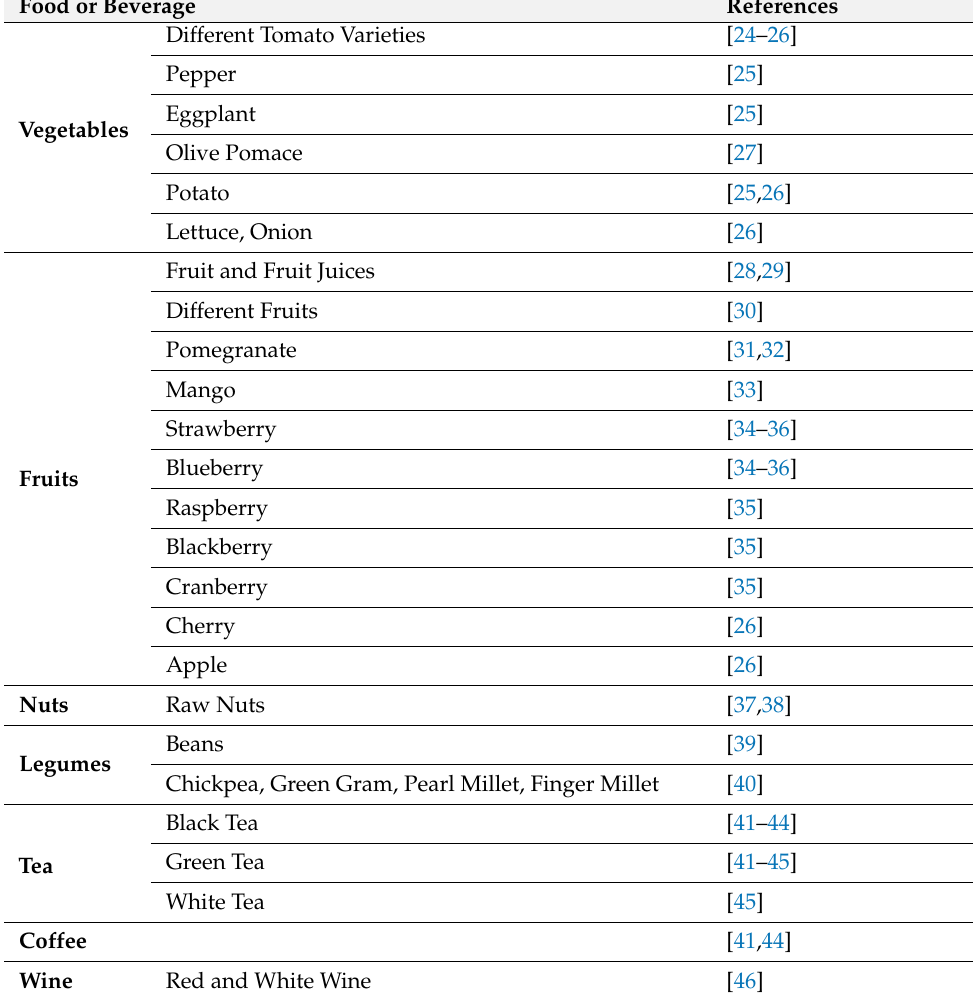
Table 1. Food and beverages with high polyphenolic